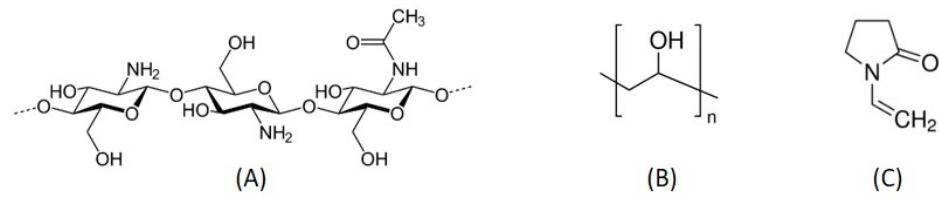
Figure 1. Schematic representation of: ( A ) Chitosan; ( B ) PVA; ( C ) VP.